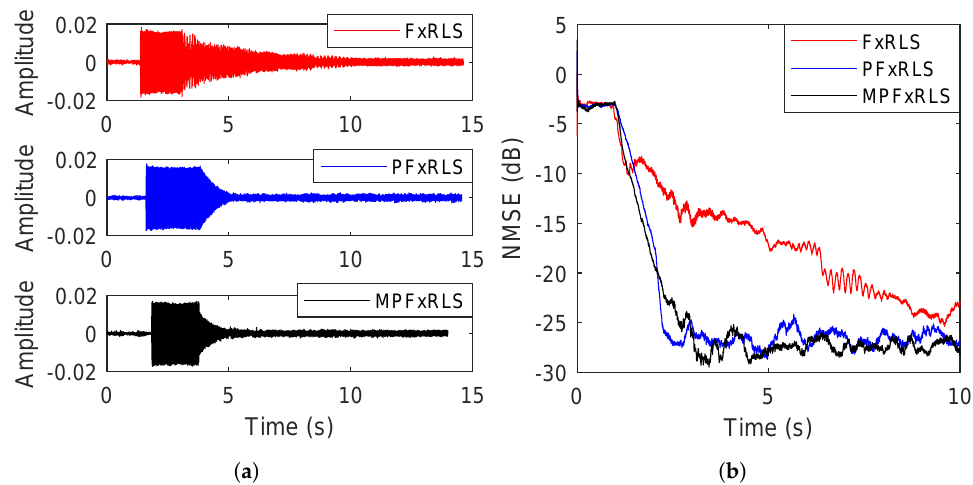
Figure 9. De-noising result for small forgetting factor λ = 0.99: ( a ) shows the result of residual error. ( b ) shows the result of